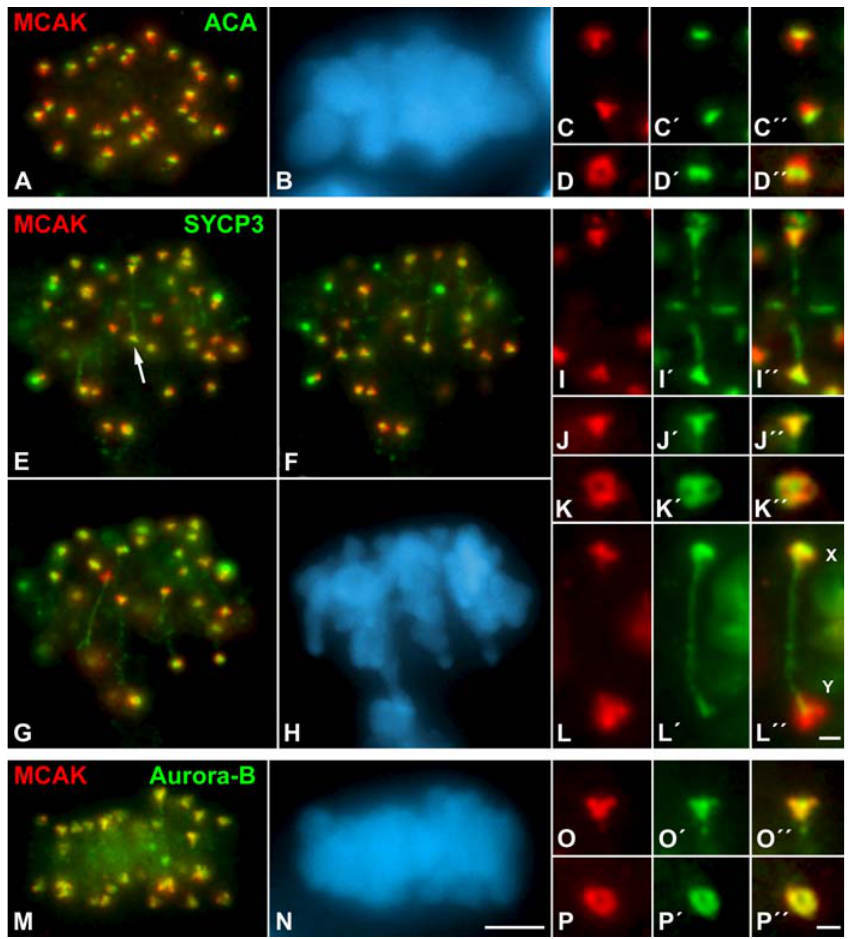
Figure 2. MCAK and Aurora-B Colocalise at the Inner Domain of Metaphase I Centromeres MCAK is labelled in red and kinetochores (A–D 99 ), SYCP3 (E–L 99 ), and Aurora-B (M–P 99 ) are labelled in green. In merged images colocalisation regions appear in yellow. DNA appears in blue. All images are z-projections of several focal planes throughout the metaphase I spermatocytes shown. (A,B ) Metaphase I. MCAK signals appear below kinetochore ones. (C–C 99 ) Side view of a metaphase I autosomal bivalent. MCAK is detected as T-like signals below, and partially colocalising with, kinetochore signals in both homologues. (D–D 99 ) Top view of an autosomal metaphase I centromere. MCAK